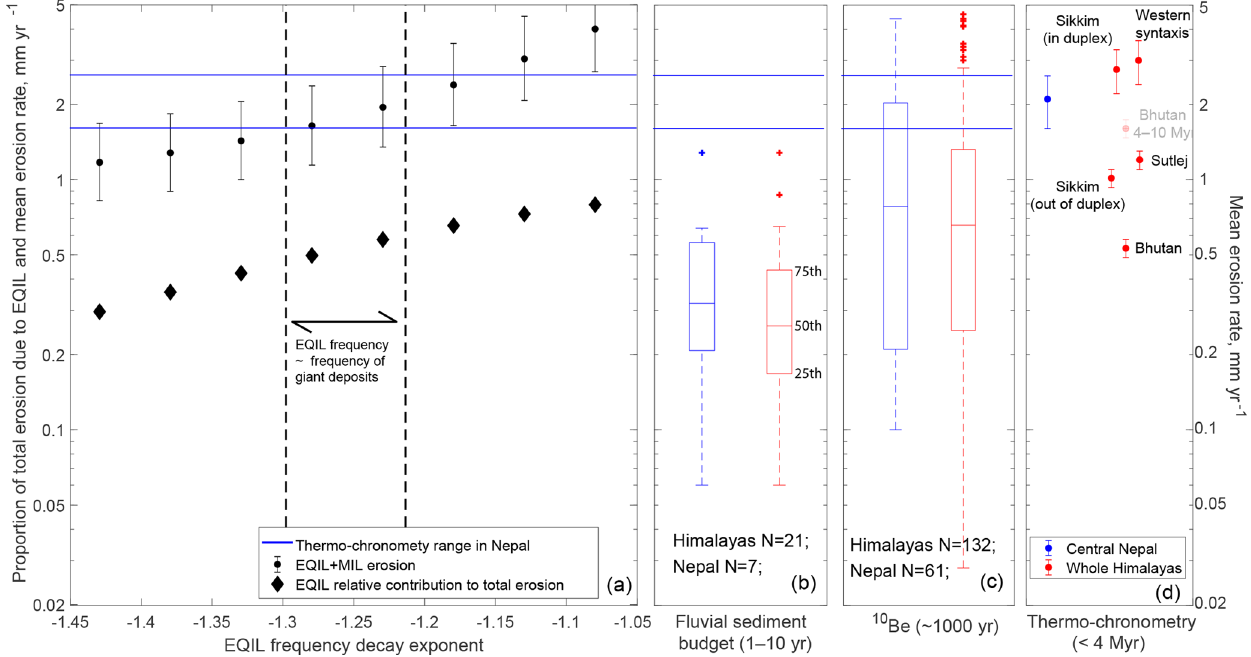
Figure 7. Long-term erosion rates (circles with uncertainty bars) obtained by integrating and summing the earthquake and monsoon best-fit distributions (converted into volume), as a function of the modelled decay exponent of the size distribution of EQIL (a) . EQIL distribution takes into account all earthquake magnitudes as well as the post-seismic landslide contribution. The proportion of erosion due to earth- quakes in the different scenarios is shown by the black diamonds. Erosion rates estimated from fluvial sediment budget (1- to 10-year scale, b ), 10 Beryllium catchment-wide concentration (1000-year scale, c ) and thermo-chronometric methods (million-year scale, d ) in cen- tral Nepal (blue) and the Himalayan arc (red). In (a) and (b) , we visualize the data for catchments between 100 and 5000km 2 , thus excluding main rivers draining large areas. Sediment budgets are from Rao et al. (1997) (Chenab), Ali and De Boer (2007) (western syntaxis), Gabet et al. (2008) (central Nepal), and Wulf et al. (2012) (Sutlej). 10 Be measurements are from Wobus et al. (2005) and Godard et al. (2012, 2014) for central Nepal, Scherler et al. (2014) in the Sutlej, Portenga et al. (2015) in Bhutan, and Abrahami et al. (2016) in Sikkim. Box plots show 25, 50 and 75 percentiles, whiskers are the furthest data within a distance equal 1.5 times the interquartile range beyond the boxlimit, and data beyond whiskers are shown as crosses. For thermo-chronometric data we report the mean and standard deviation of the denudation of the models best explaining the age compilation done by Thiede and Ehlers (2013) for the Greater Himalayas sequence in the western syntaxis, the Sutlej, central Nepal and Bhutan. In Sikkim, erosion estimates for within and without a zone interpreted as a duplex are from Landry et al. (2016) and Abrahami et al. (2016),